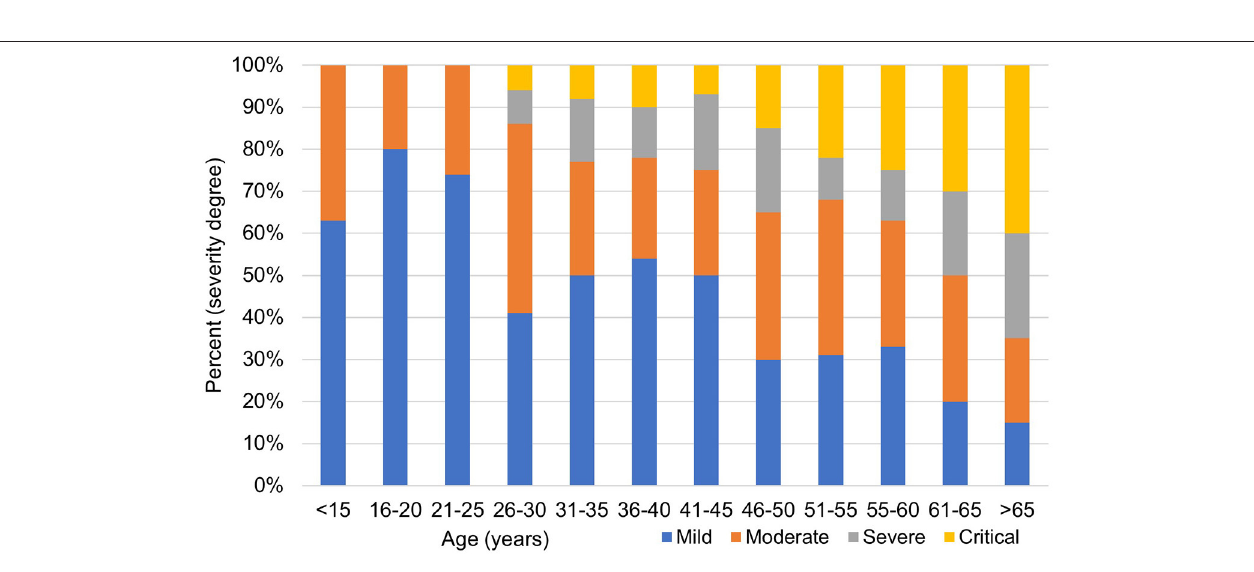
FIGURE 2 | The clinical severity of confirmed cases of COVID-19